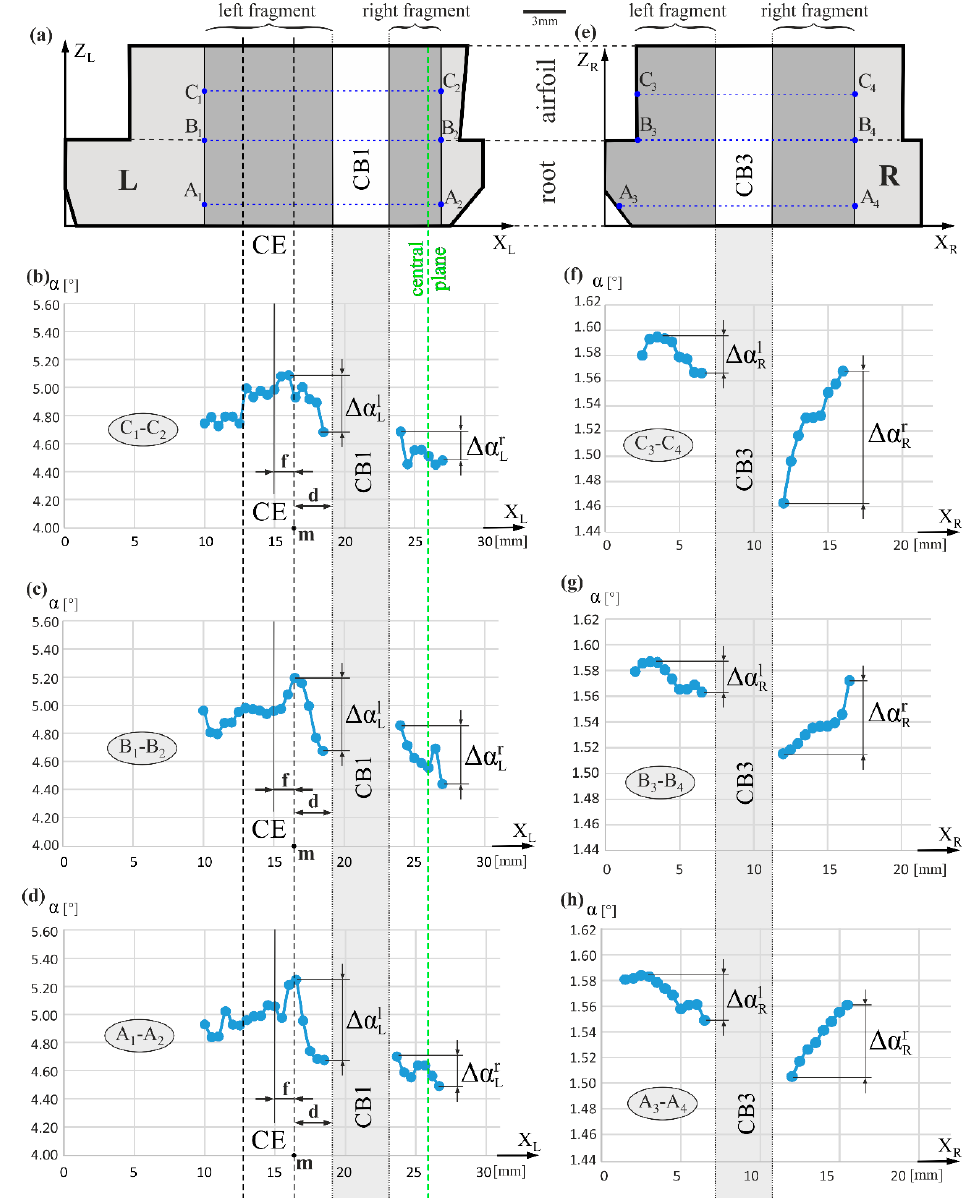
Figure 3. Schema of the arrangement of the α angle measurement lines ( a , e ), and the α values distribution on the fragments of the L ( b – d ) and R ( f – h ) surfaces along these lines in the vicinity of the cooling bores (CB1 and CB3). The labels of the measurement axes are replaced by parallel axes X L and X R for simplicity of analysis.